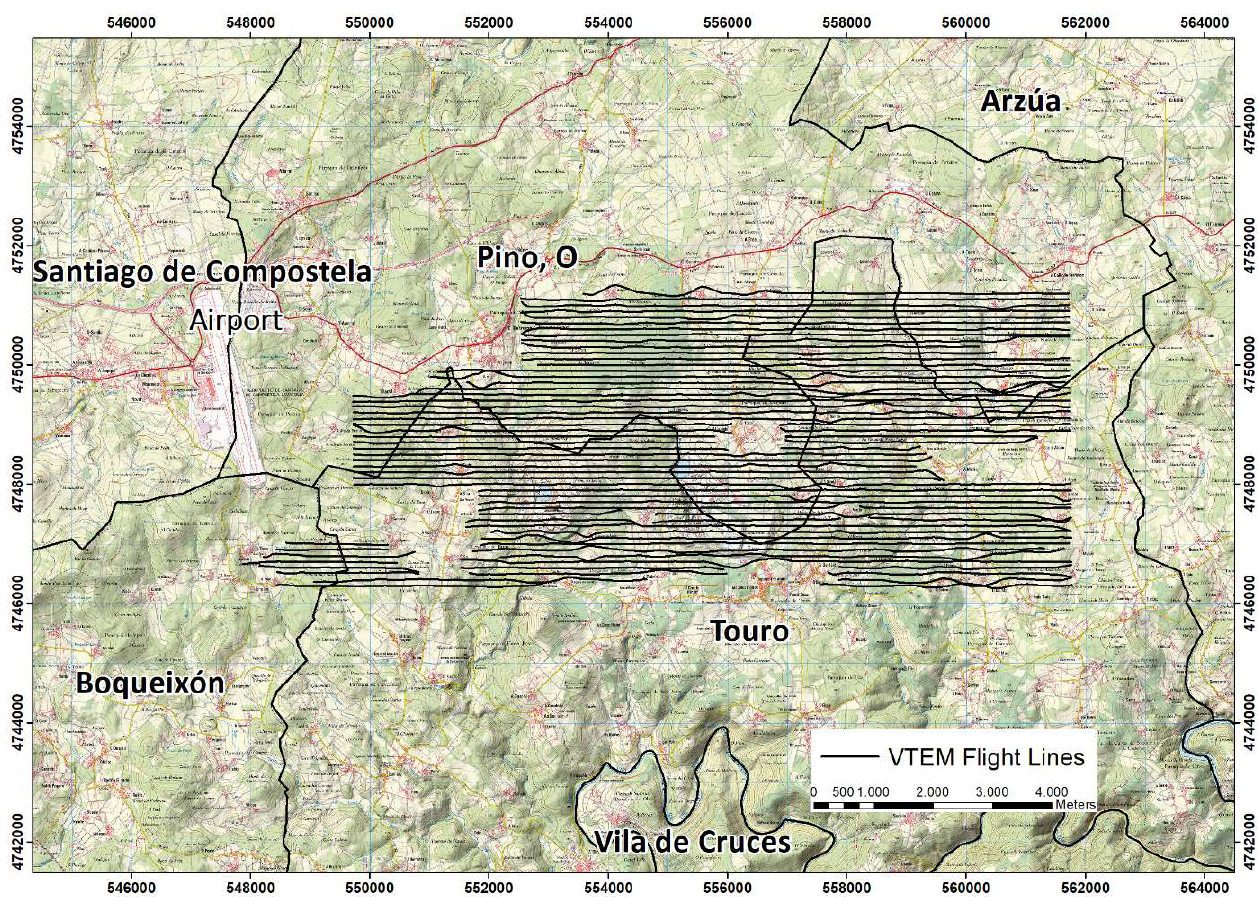
Figure 3. VTEM flight path on a topographic map of the area.